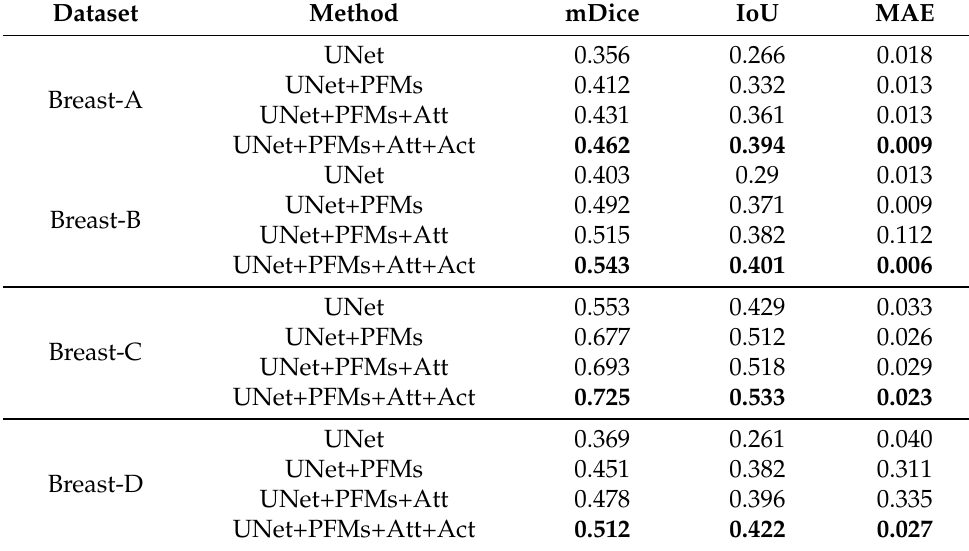
Table 1. Ablation experiments with different network structure designs on Breast-A, Breast-B, Breast- C and Breast-D datasets, where PFMs, Att and Act represent multiple promotion feature modules used in the basic segmentation model, the proposed attention-based sampling scheme and the proposed active labeling strategy,